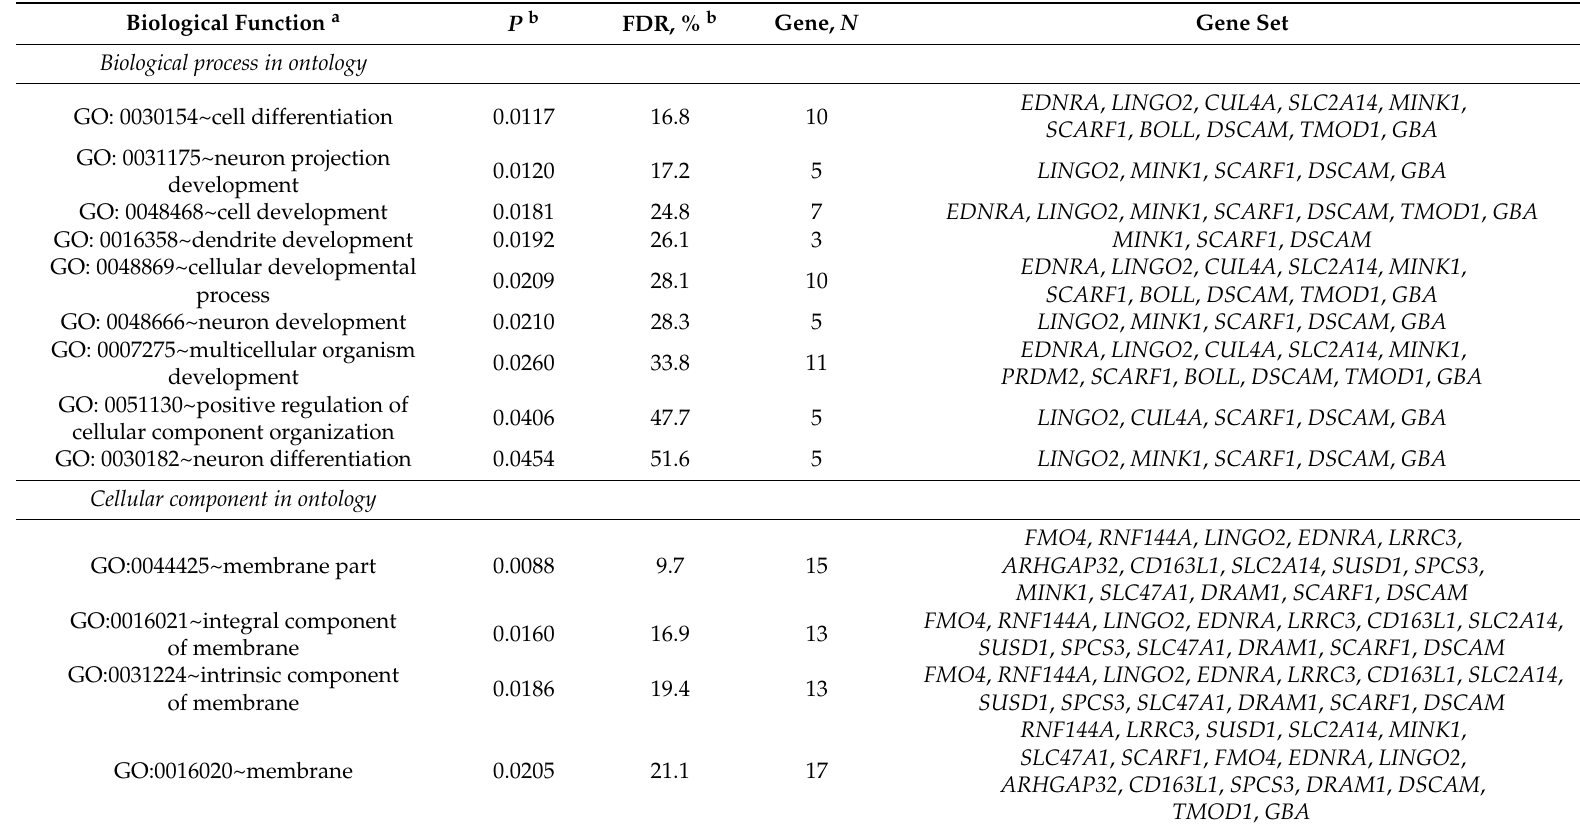
Table 3. Gene enrichment functional analysis using candidate genes for susceptibility to intracranial aneurysms ( p < 0.05). Biological Function a P b FDR, % b Gene, N Gene Set Biological process in